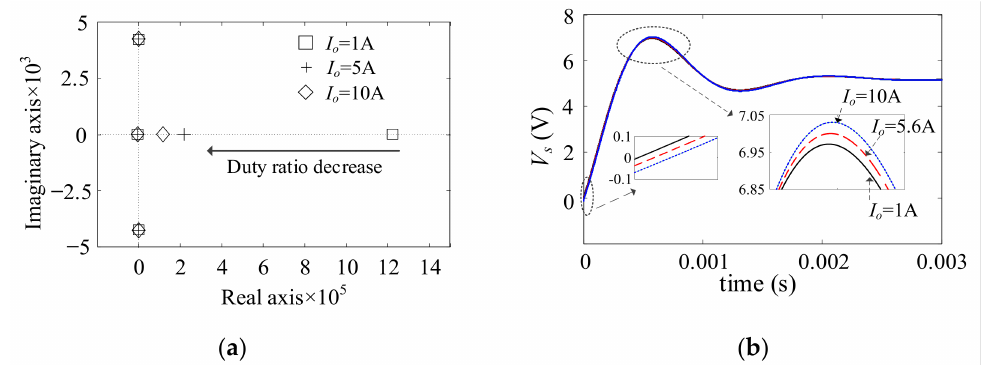
Figure 7. The influence of different loads on the system at the same input voltage. ( a ) The position of zeros and poles. ( b ) Step